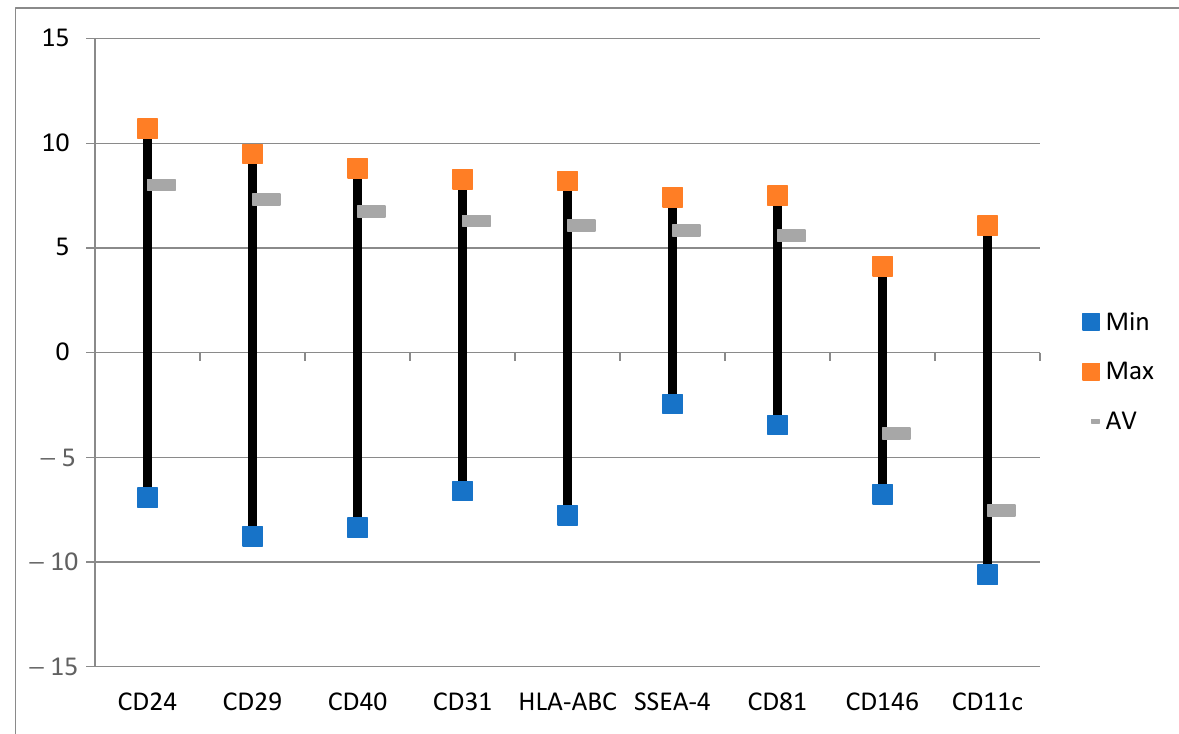
Figure 8. Effects of ALA alone on selected exosomes with the lowest variabilities. The data are presented as minimal, maximal, and average log values. Log = sgn (ALA i − Ctrl i )*log 2 (|ALA i − Ctrl i |), where ALA i is the exosome fluorescence intensity in the group with ALA alone and Ctrl i is the exosome fluorescence intensity in the control group with no ALA or light.